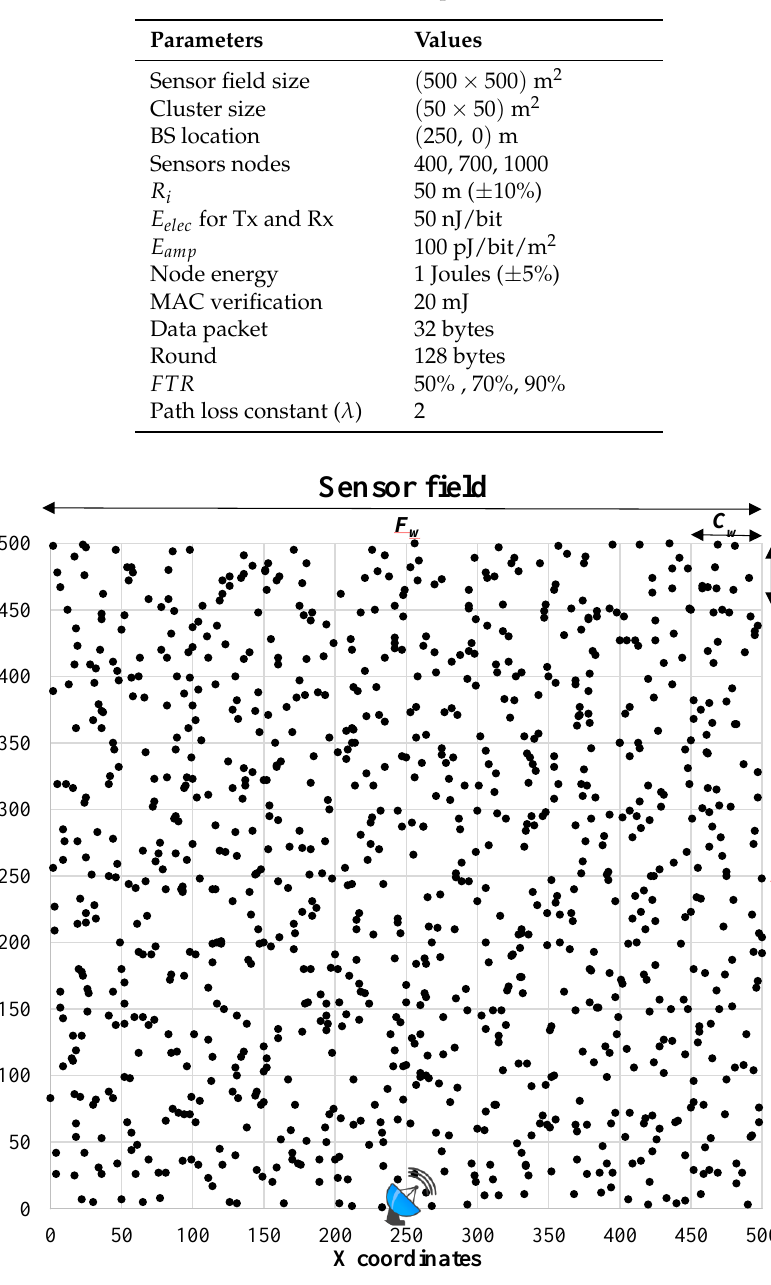
Table 1. Simulation parameters.